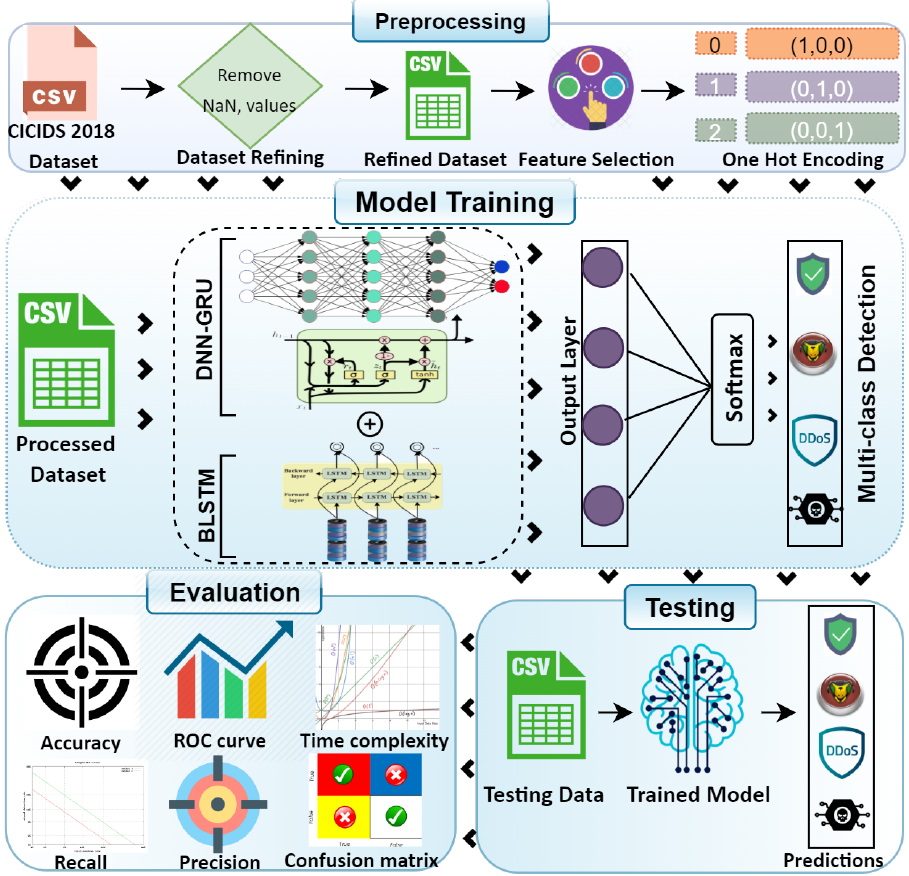
Figure 2. Proposed hybrid detection